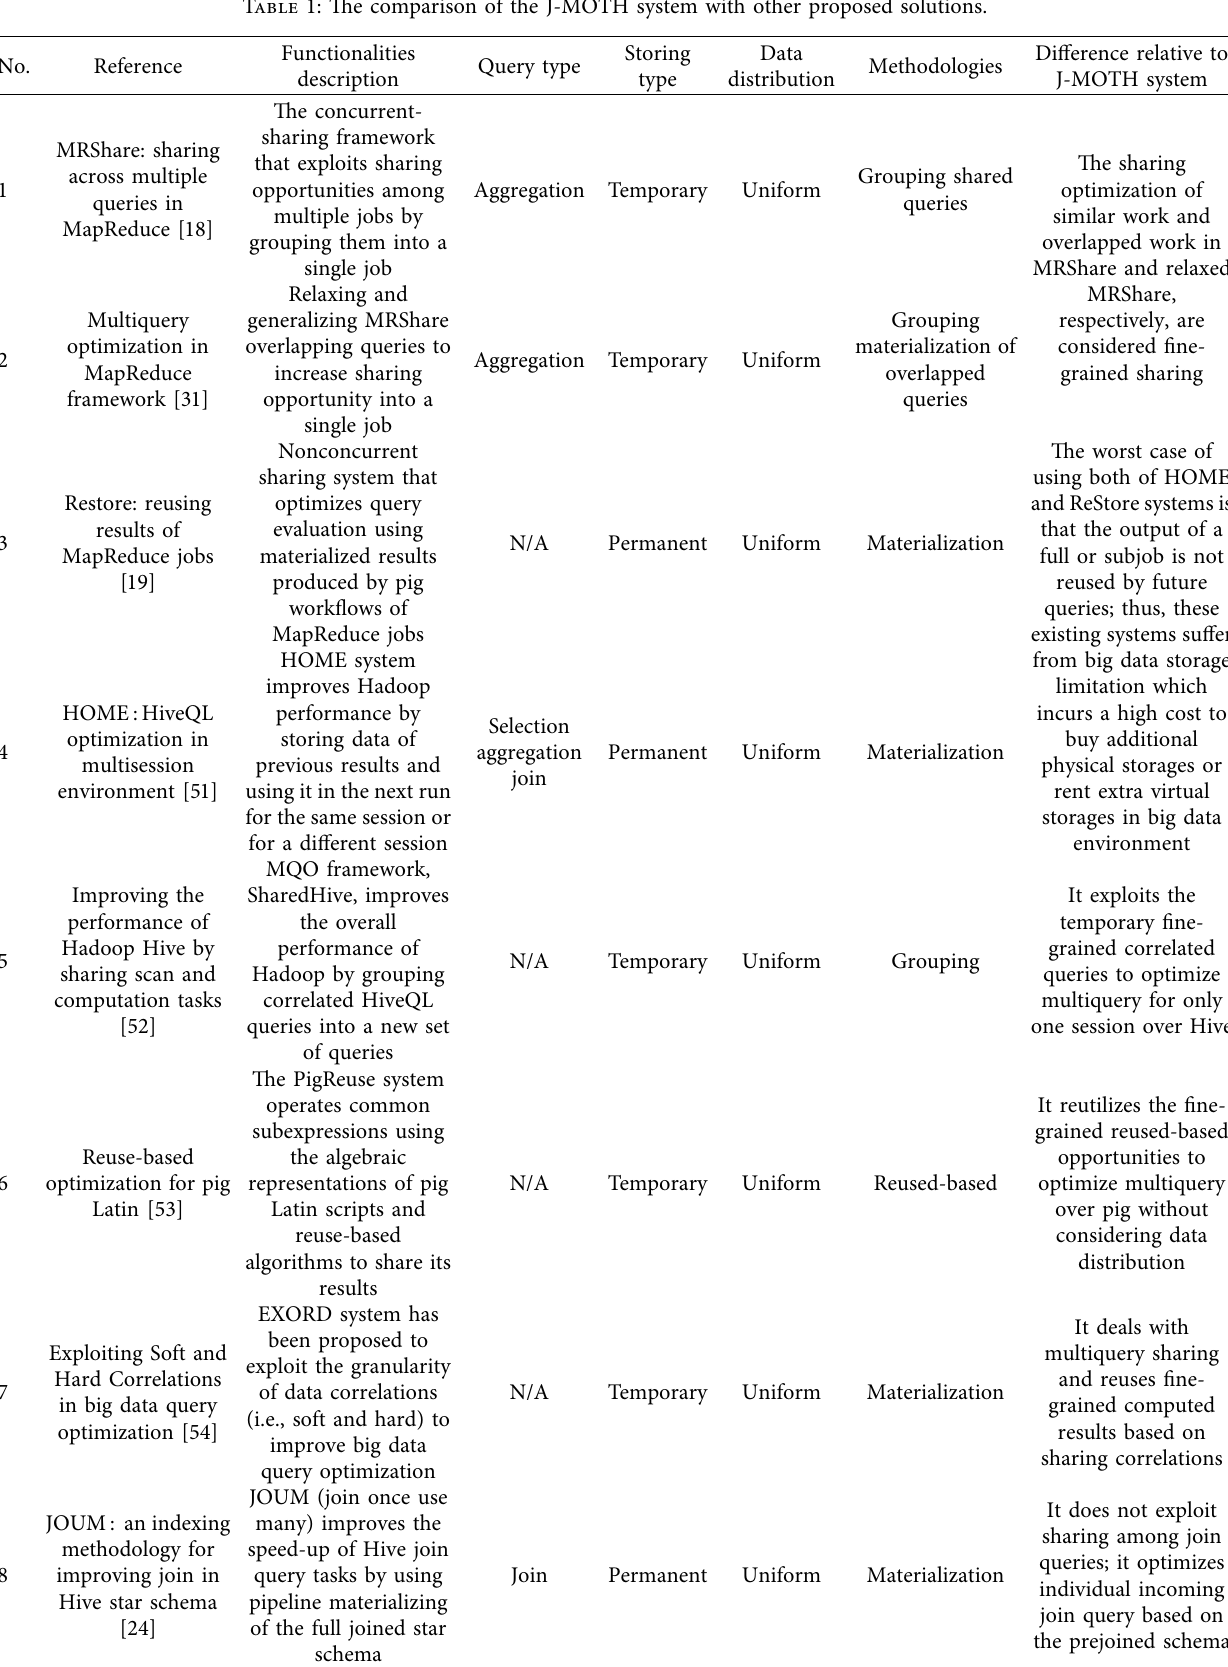
Table 1: The comparison of the J-MOTH system with other proposed